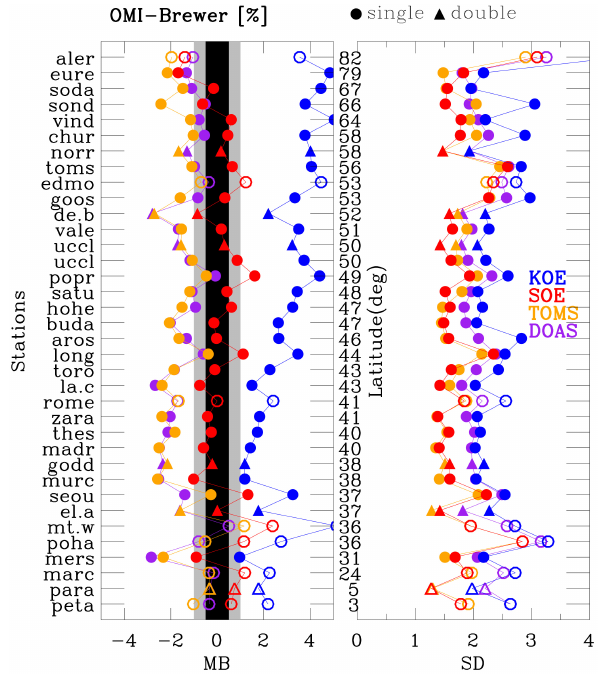
Figure 1. Mean biases and 1 σ standard deviations comparing OMI and Brewer total column ozone at the 35 Brewer stations listed in Table 2. The color coding indicates the comparisons for four to- tal column ozone data sets derived through KOE, SOE, TOMS, and DOAS algorithms. The circle and triangle symbols indicate single and double Brewer stations, respectively. The filled and opened symbols represent stations selected and rejected, respec- tively, through the reference selection procedure done in Sect.